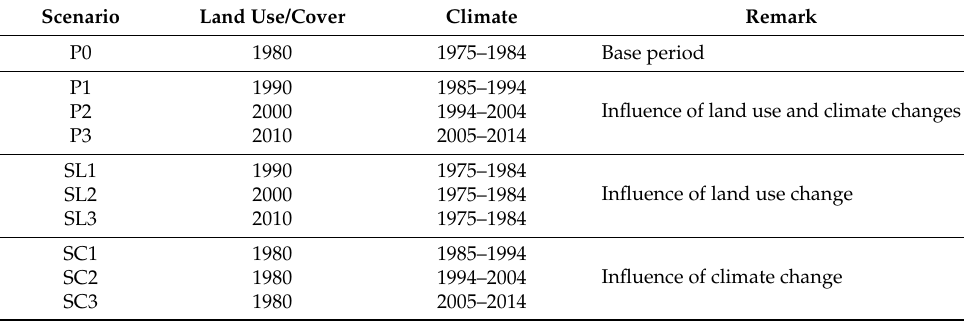
Table 1. Real simulation scenarios of land use and climate